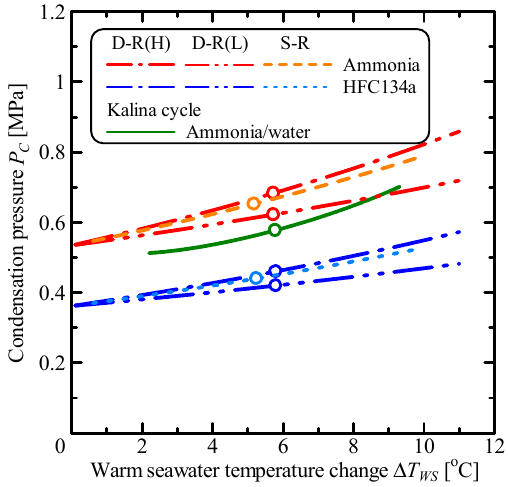
Figure 13. Relationship between the condensation pressure and the warm seawater temperature change.